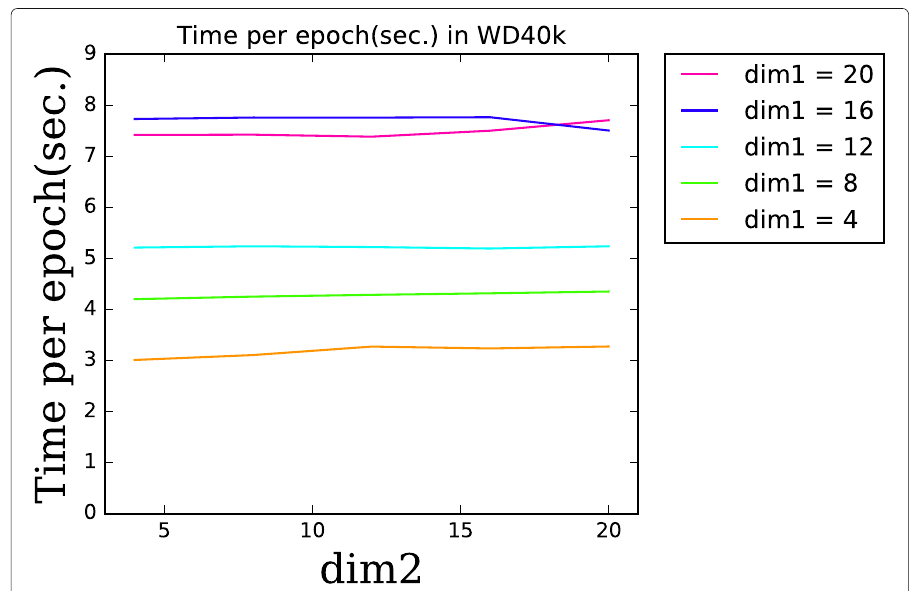
Fig. 5 Computational time of KGML for different embedding